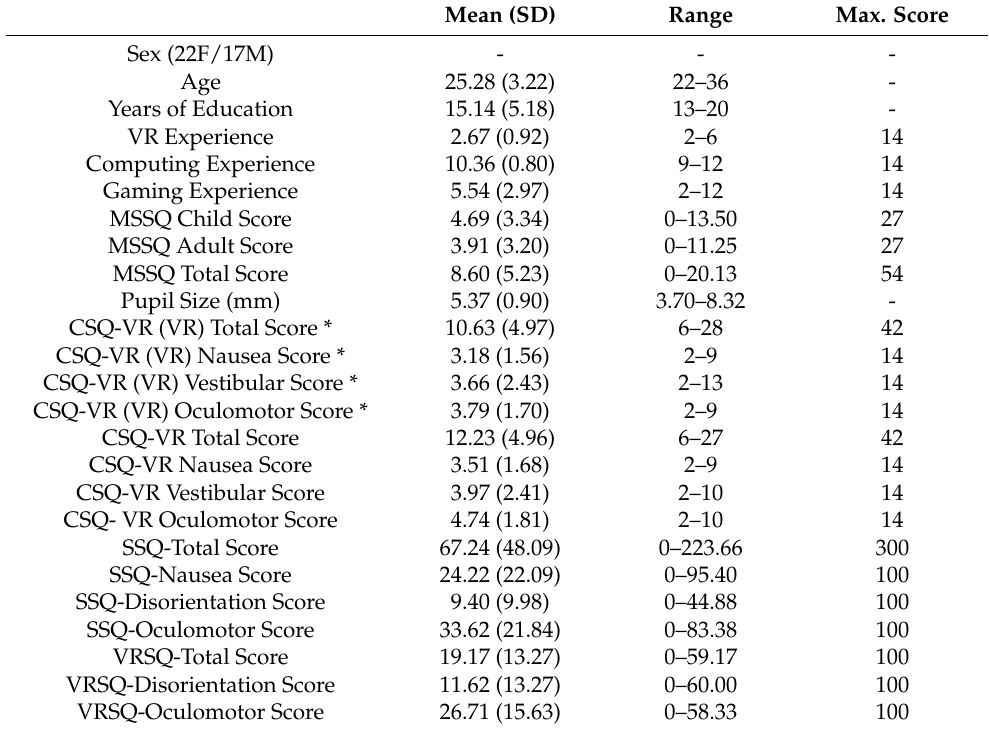
Table 1. Descriptive Statistics.